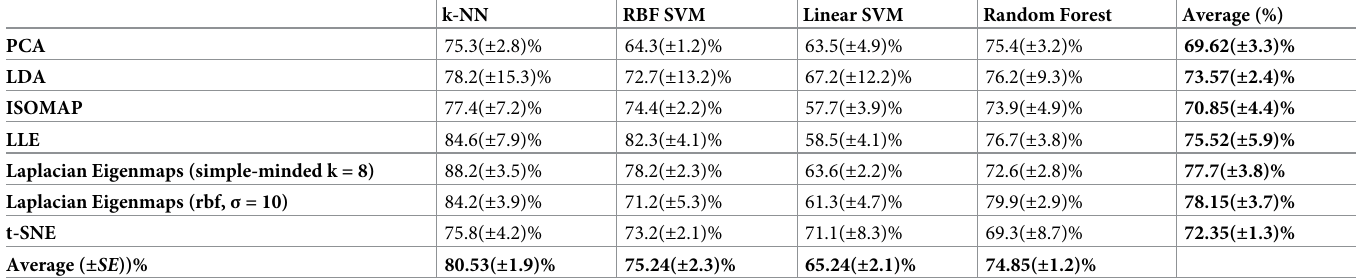
Table 4. Performance of different classifiers vs. different dimensionality-reduction methods on EMG signals (F1 score ± SE). See S4 Table in S1 Text for post-hoc t- tests for this